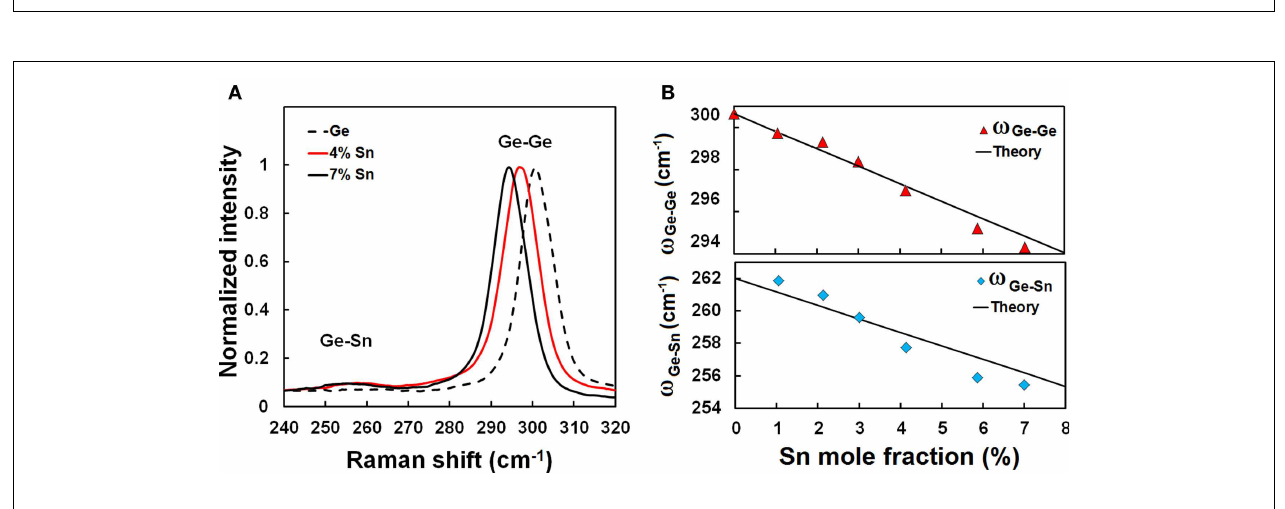
Sn mole fraction.The solid symbols are experimental data and the curves are theoretical predictions for relaxed films.The Ge–Ge peak is expected to shift 0.8310cm − 1 for every 1% Sn incorporation in relaxed films.The expected shift (0.8311cm − 1 ) for Ge–Sn peak is very close to that of